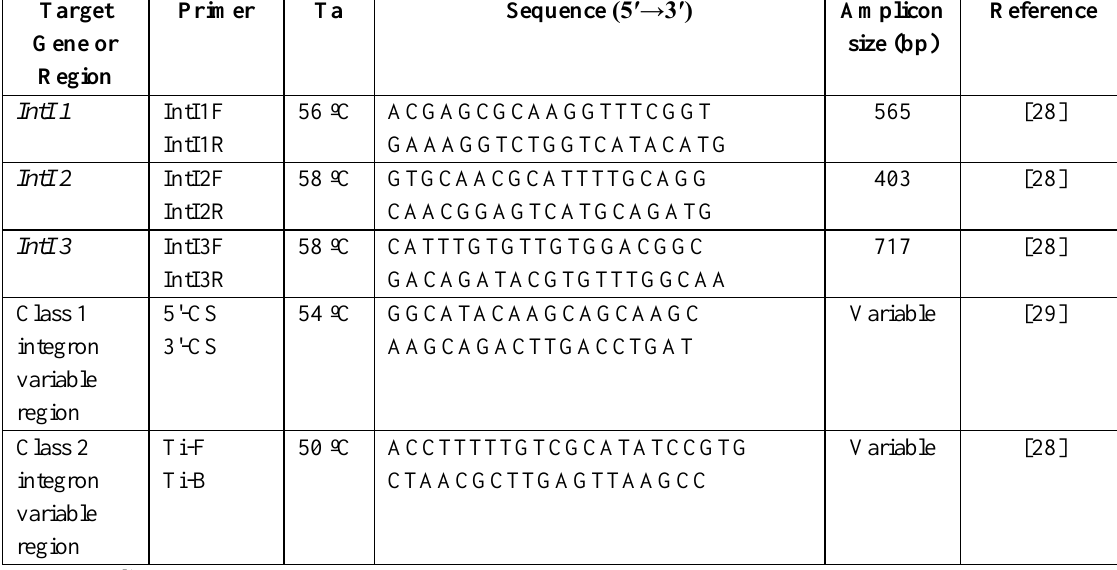
Table 1. List of primers used for the detection of the target genes.